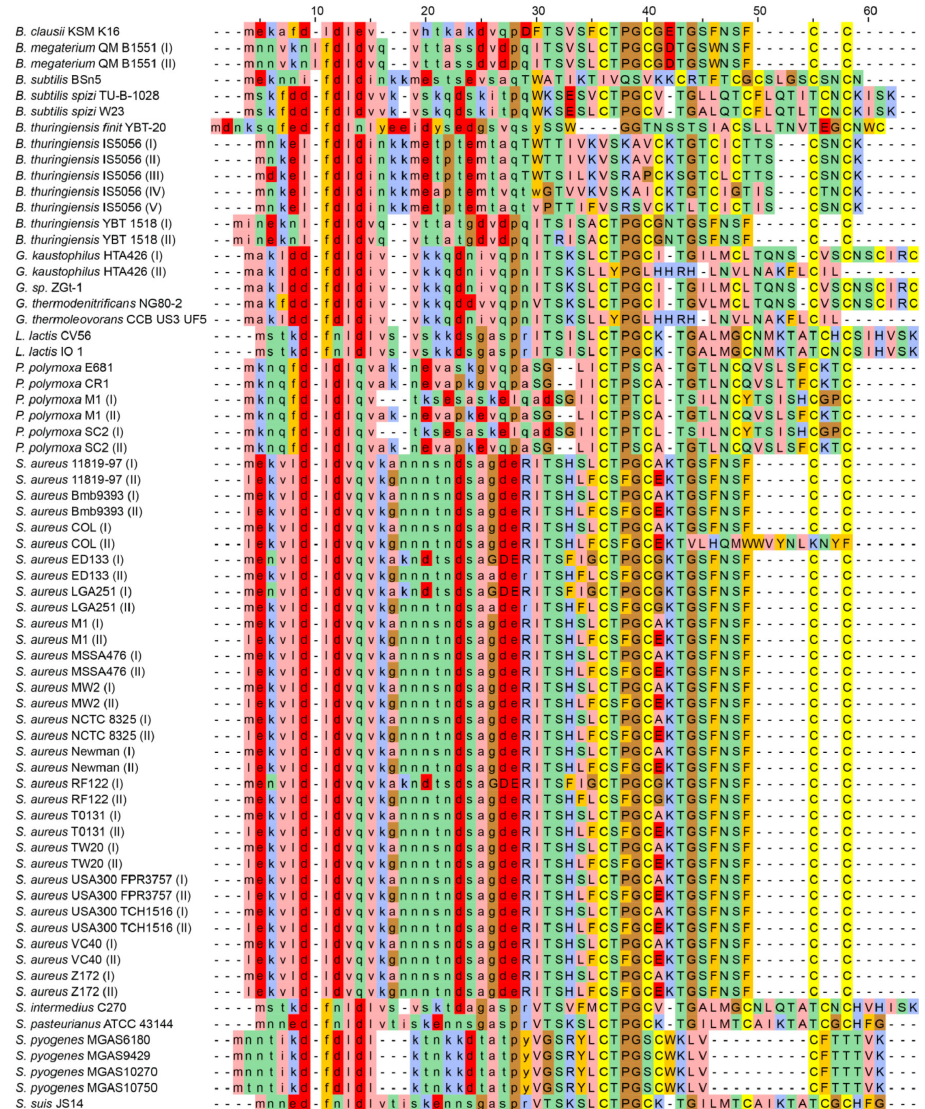
Figure 2. Alignment of all identified class-I LanA precursors with the exception of the lanthipeptide of Streptococcus intermedius strain B196 which aligned poorly. Leader peptides are in lower case and are reported as shown in the results of antiSMASH. No manual editing of the alignment was performed. For the full name of bacterial species, see Table